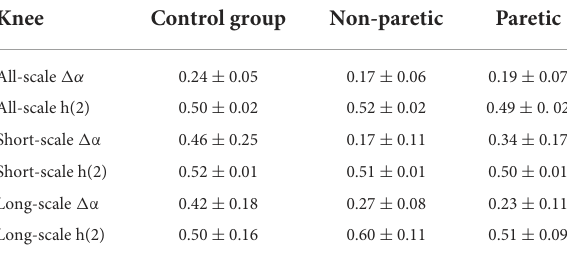
TABLE 2 Mean and standard deviation for the shuffled series on ankle among the paretic limbs and the non-paretic limbs of a patient with stroke and the control